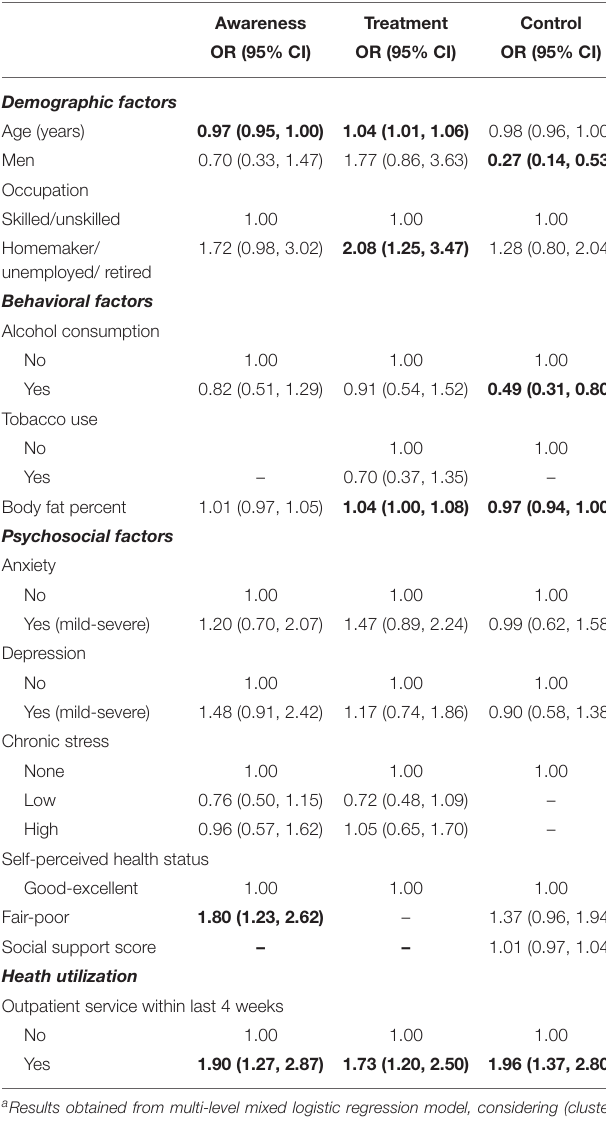
TABLE 5 | Factors associated with hypertension awareness, treatment, and control over 2-year follow-up among hypertensive participants a .